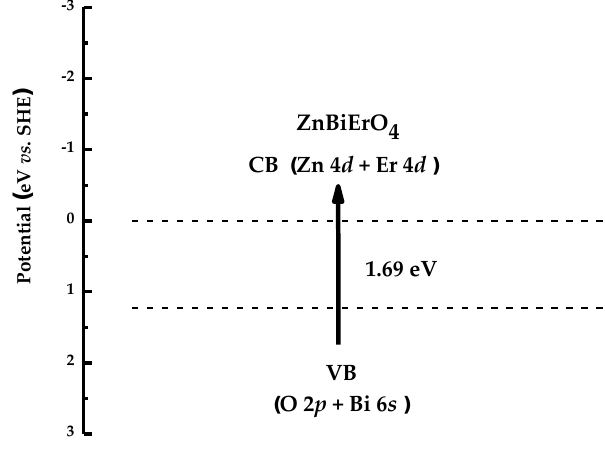
Figure 22. Suggested band structure of ZnBiErO 4 .